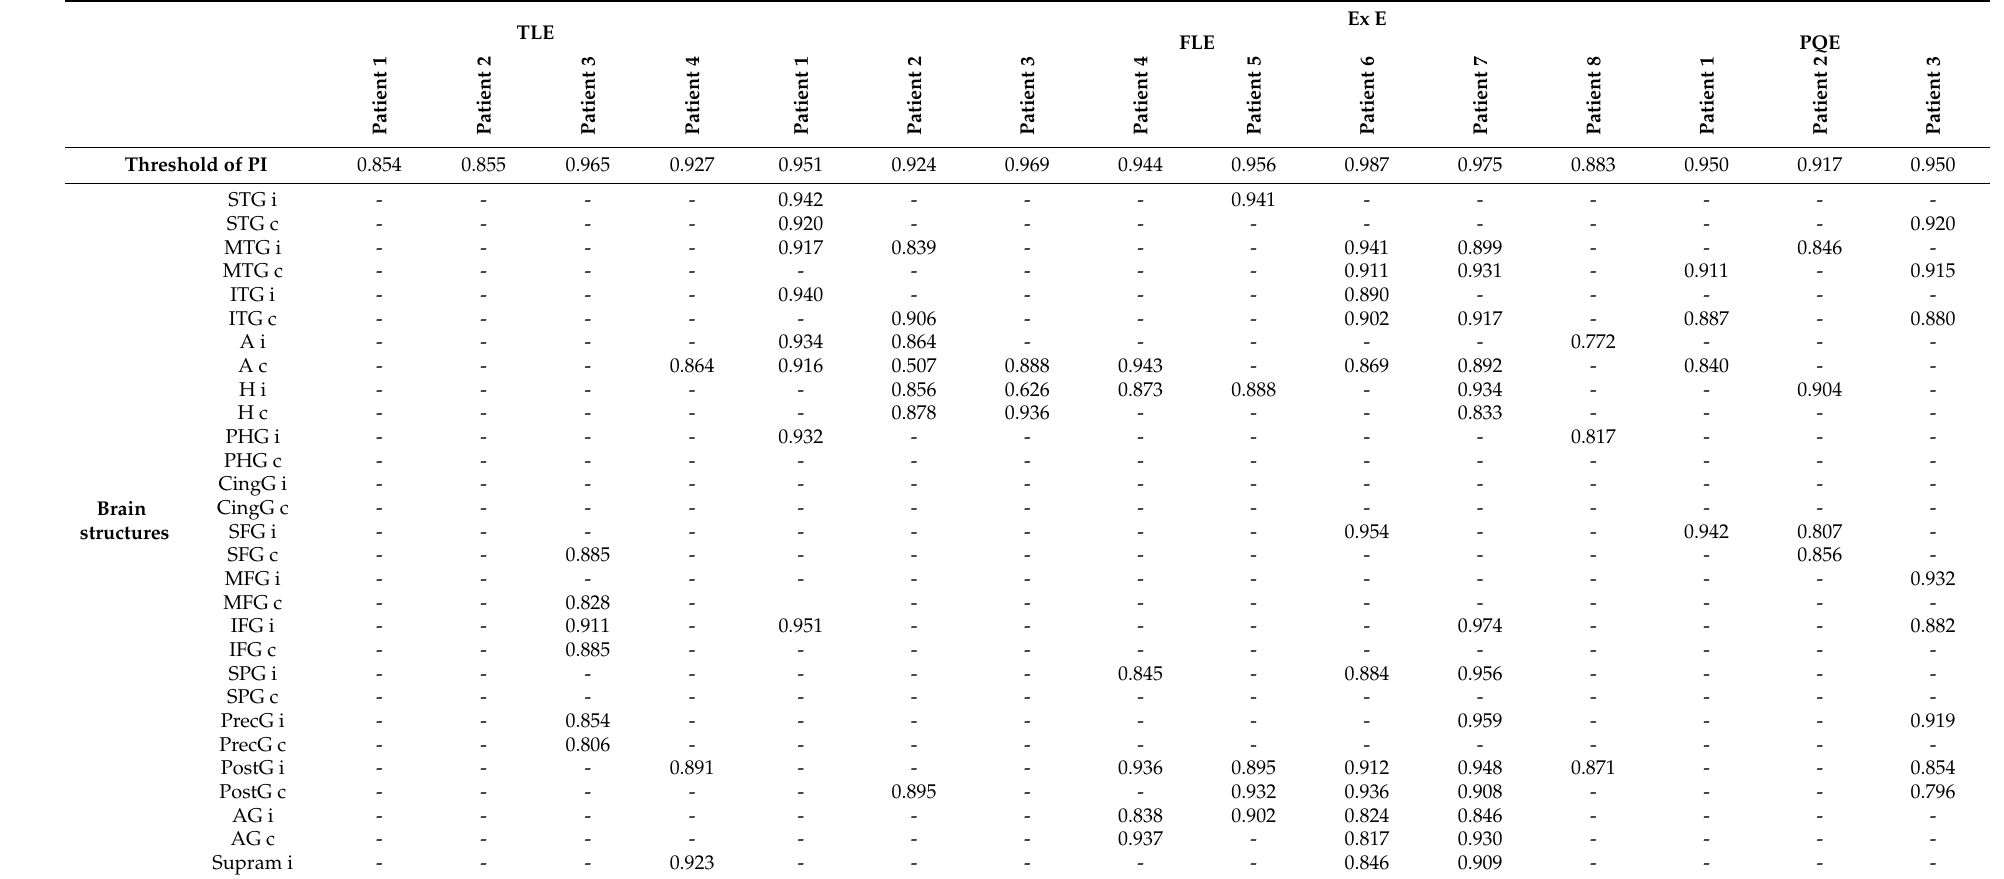
Table 3. Brain structures with values lower than the established threshold of Perfusion Index (interictal